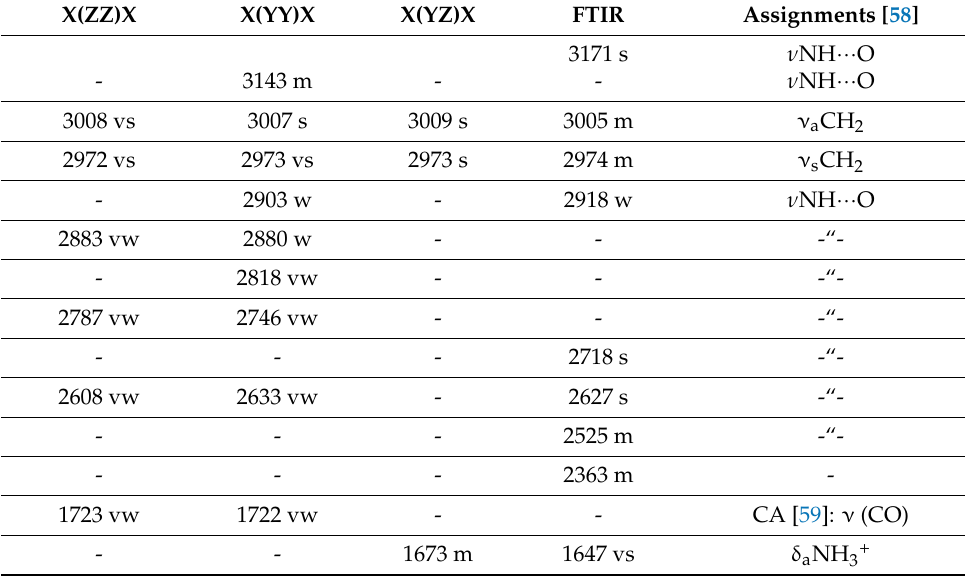
Table 9. Positions of lines ( ν , cm − 1 ) observed in polarized Raman and FTIR spectra of α -Gly:CA (90:10) crystals and assignments of analogous lines in nominally pure α -Gly from Ref.